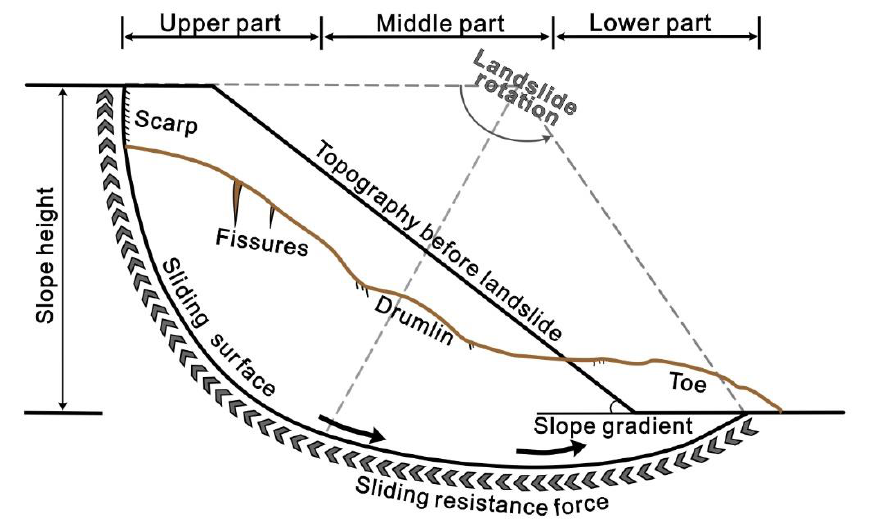
Figure 12. Failure mode analysis of Lianluo landslide.